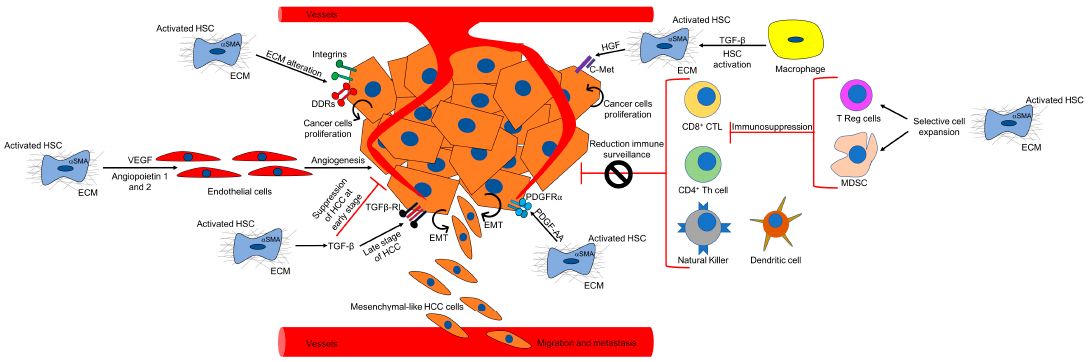
Figure 2. TME in HCC. The figure outlines the different components of the TME and the CAF- dependent mechanisms of hepatocarcinogenesis. (See text for